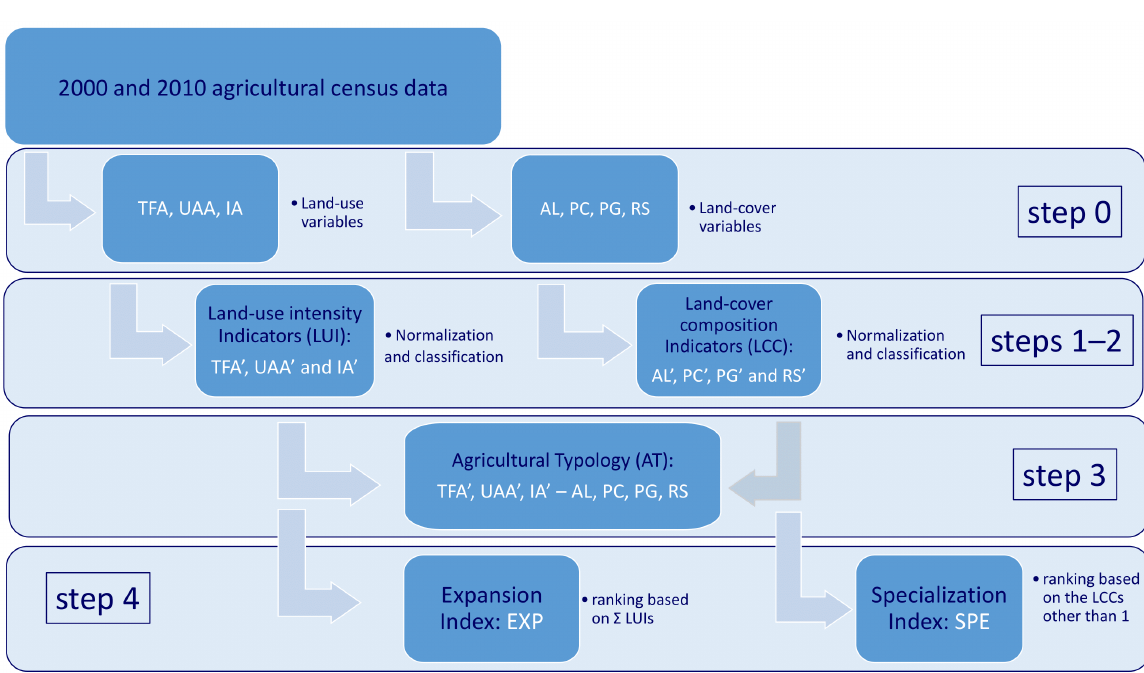
Figure 2. Step by step scheme of the methodology used to analyze census data (step 0: variable selection; step 1–2; calculation of indicators; step 3: assignment of agricultural typology (AT) and step 4: indices calculation).